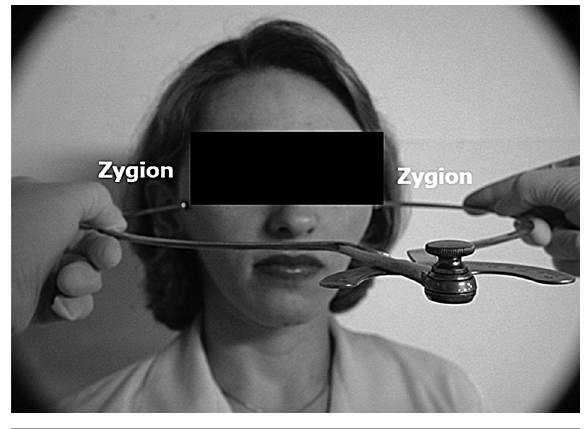
Figure 3. Face width (zygion-zygion: